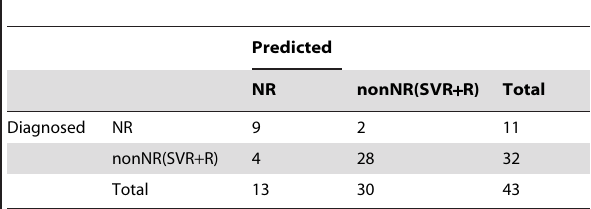
Table 5. Quality of NR-prediction by DLDA.